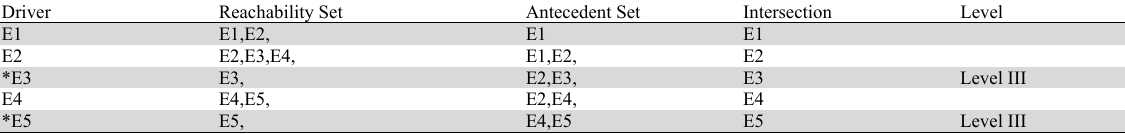
Level Partition-iteration 3